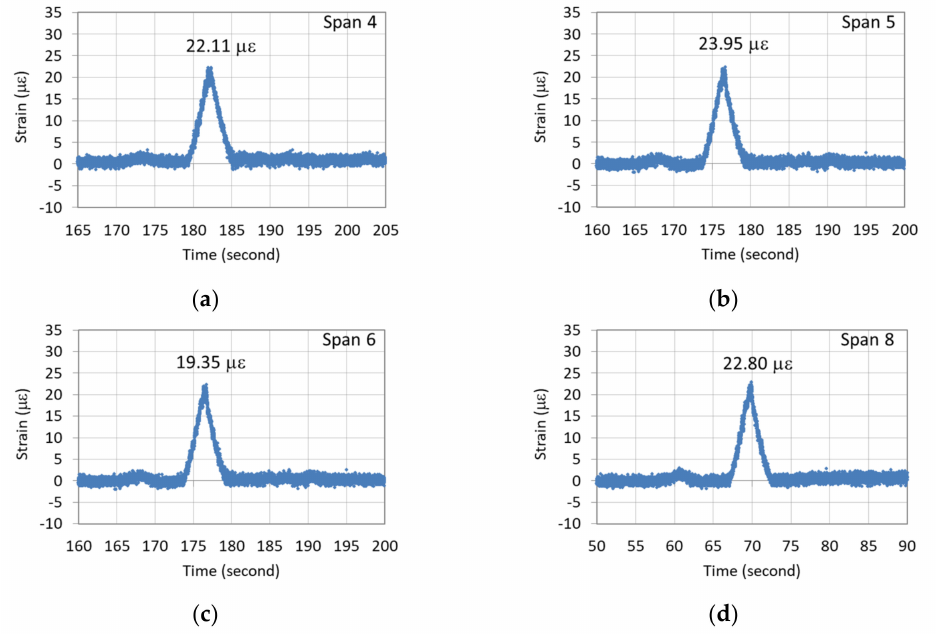
Figure 9. Dynamic strain responses of the G5 girders of the northward spans when the vehicle passed over the girders: ( a ) Span 4; ( b ) Span 5; ( c ) Span 6; ( d ) Span